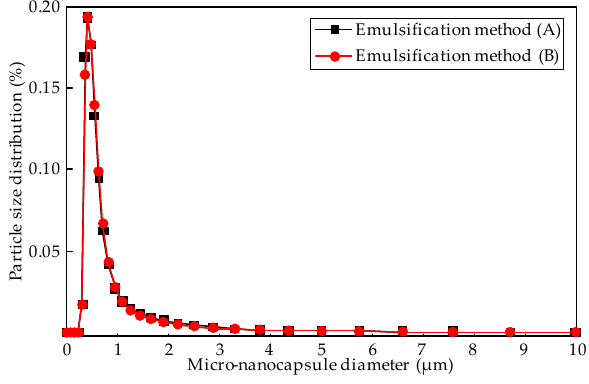
Figure 5. Particle size distribution of M ‐ NEPCMs prepared with emulsification Methods (A) and (B).